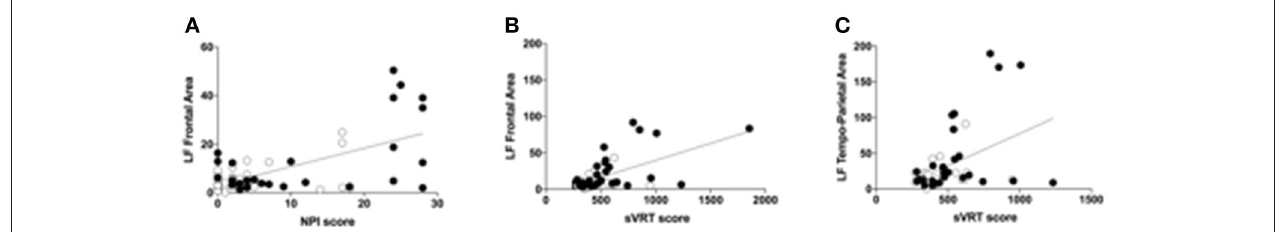
FIGURE 3 | Correlations between qEEG and clinical variables (A) . Scatter plot of the correlation between the low-frequency (LB) band power calculated in the frontal area and the NPI scores. Black circles represent the values during the Anodal tDCS session, while the white circles represent the values during the Sham tDCS session. The scatter plot represents all the values at all time points (T0, T1, T2, and T3) (B) . Scatter plot of the correlation between the low-frequency (LB) band power calculated in the frontal area and the sVRT scores. Black circles represent the values during the Anodal tDCS session, while the white circles represent the values during the Sham tDCS session. The scatter plot represents all the values at all time points (T0, T1, T2, and T3) (C) . Scatter plot of the correlation between the low-frequency (LB) band power calculated in the temporo-parietal area and the sVRT scores. Black circles represent the values during the Anodal tDCS session, while the white circles represent the values during the Sham tDCS session. The scatter plot represents all the values at all time points (T0, T1, T2, and